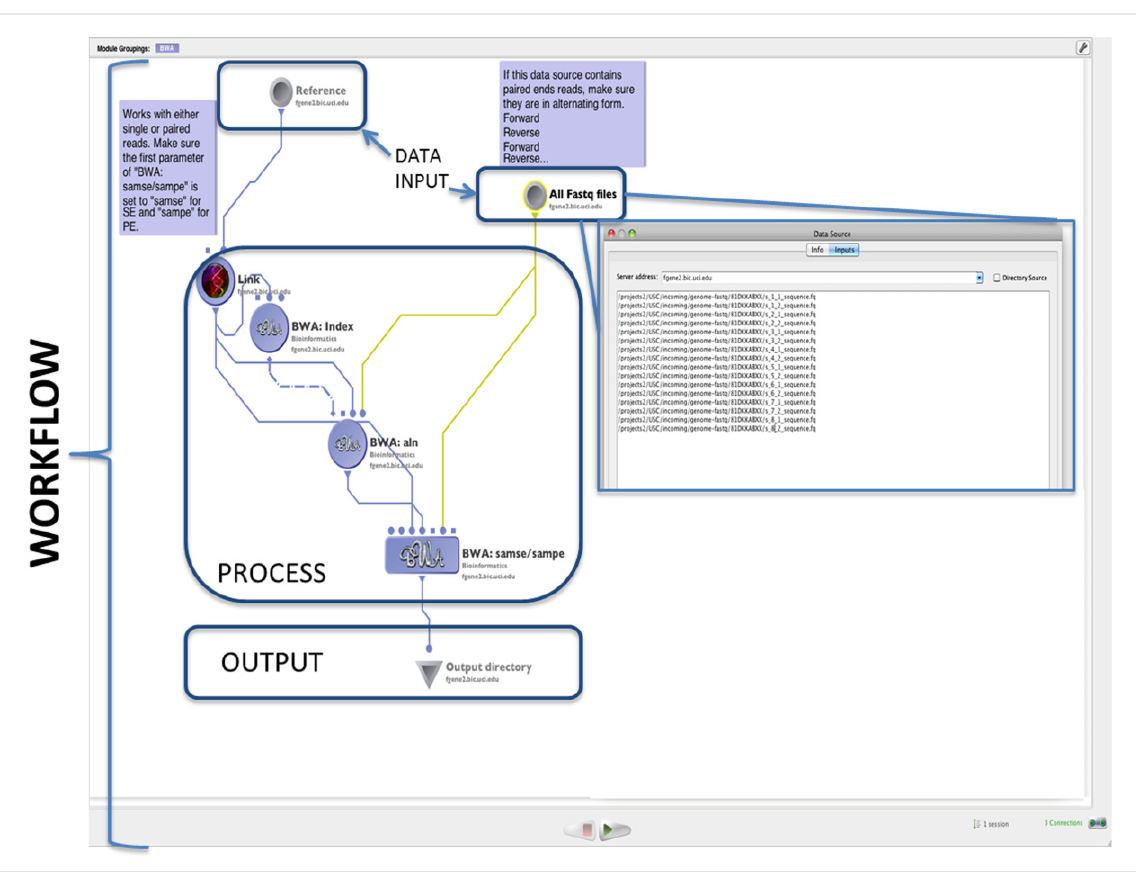
Figure 9. Snapshot from the module we used to run the alignment of an entire